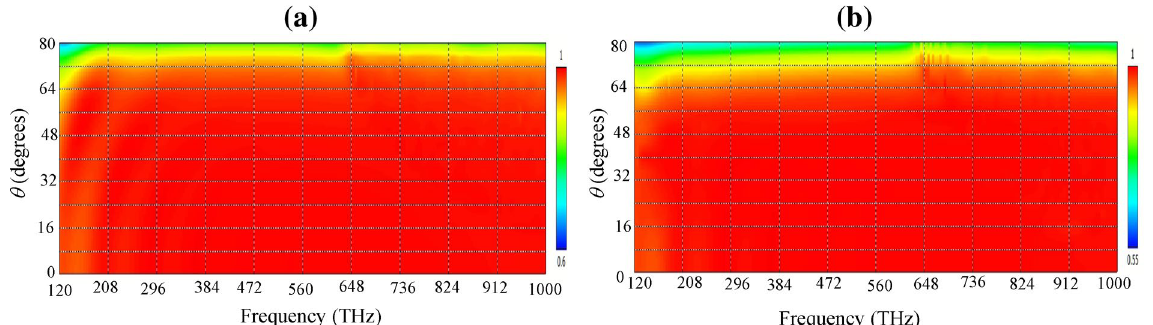
Figure 4. The sensitivity of the absorption spectrum to the incident angle for ( a ) TE and ( b ) TM